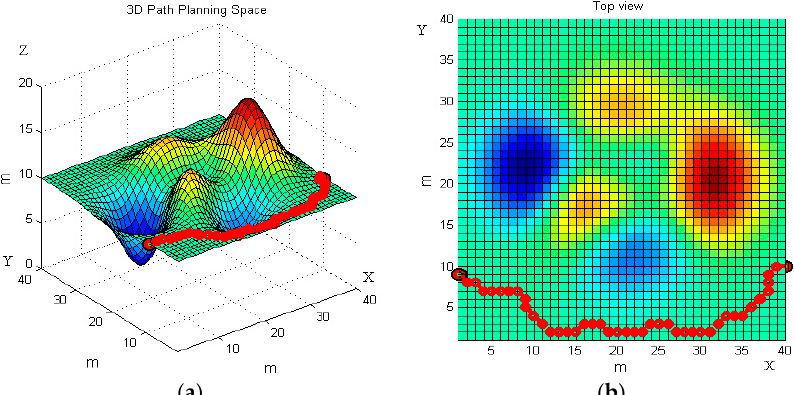
Figure 11. The robot’s moving trajectory using the basic ant colony algorithm in the second terrain. ( a ) Front view; and ( b ) top view.